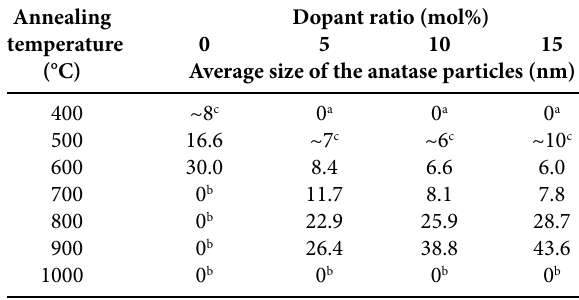
nanoparticles, b: TiO 2 2